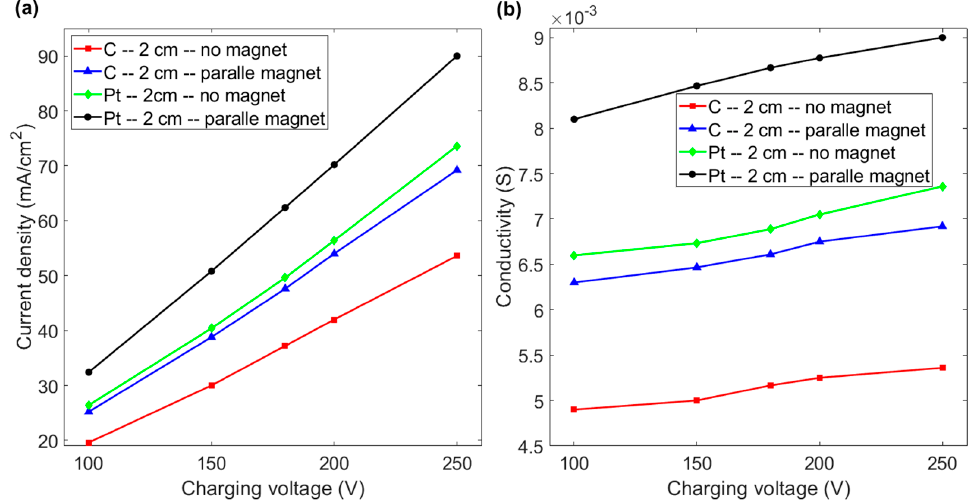
Figure 6. ( a ) Current density vs. charging voltage for graphite and platinum electrodes with and without a magnet for an inter-electrode distance of 2 cm. ( b ) Conductivity vs. charging voltage for the various experimental layouts in Figure 6a.